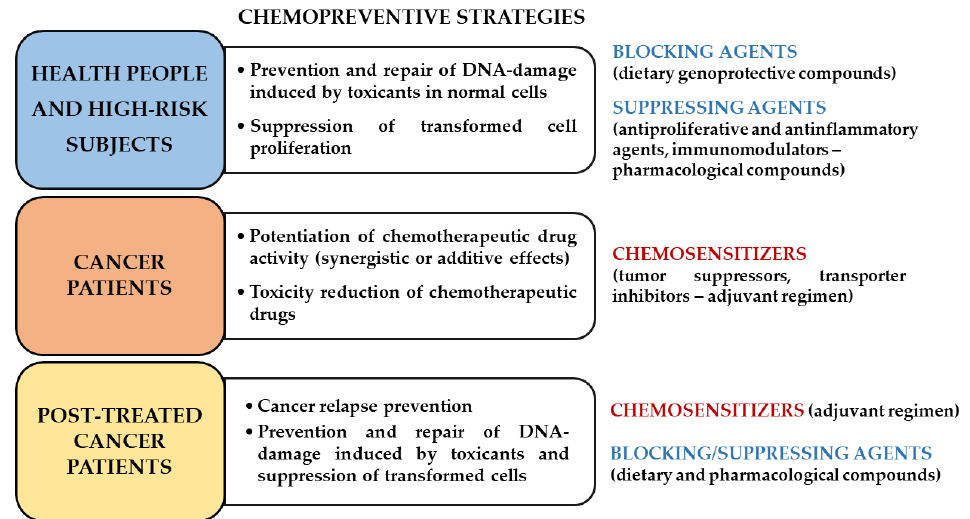
Figure 1. Role of chemoprevention in healthy people, high-risk subjects and cancer patients.